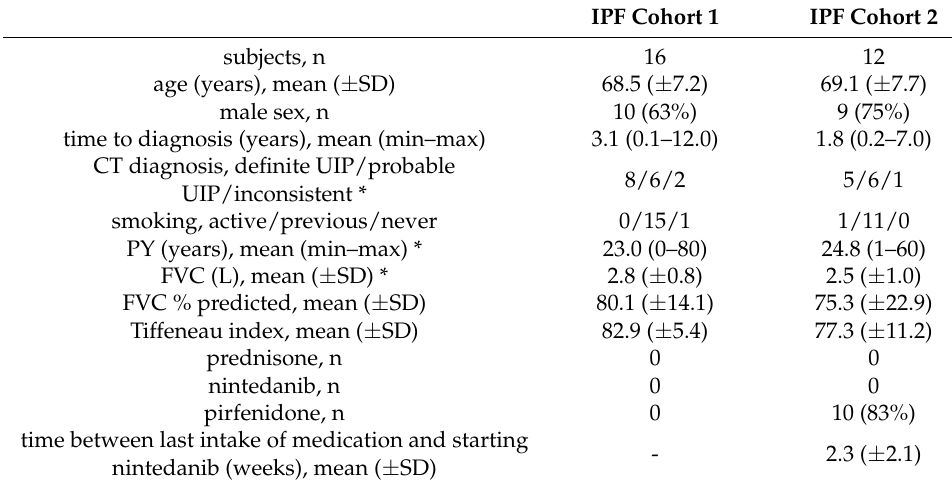
Table 1. IPF patient